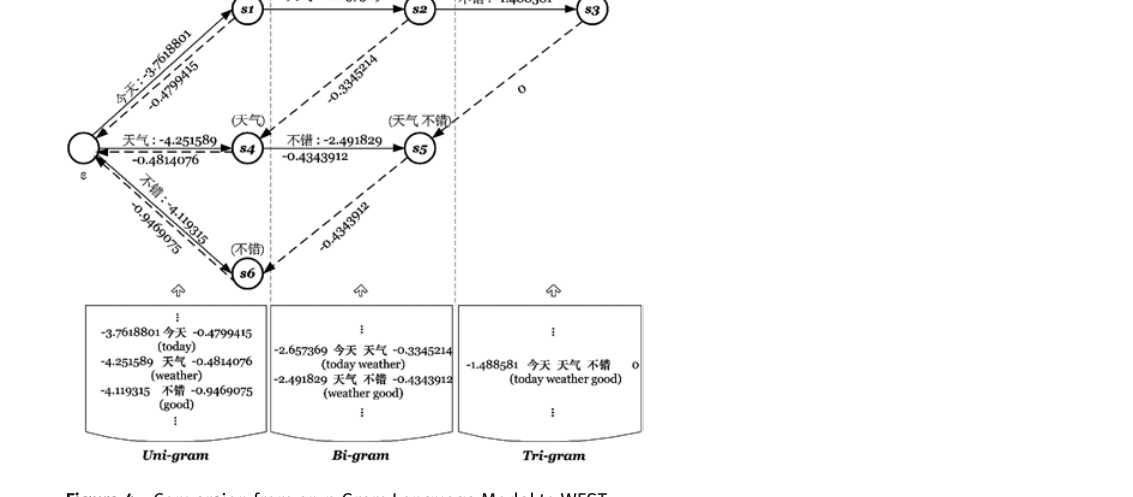
Figure 4: Conversion from an n -Gram Language Model to